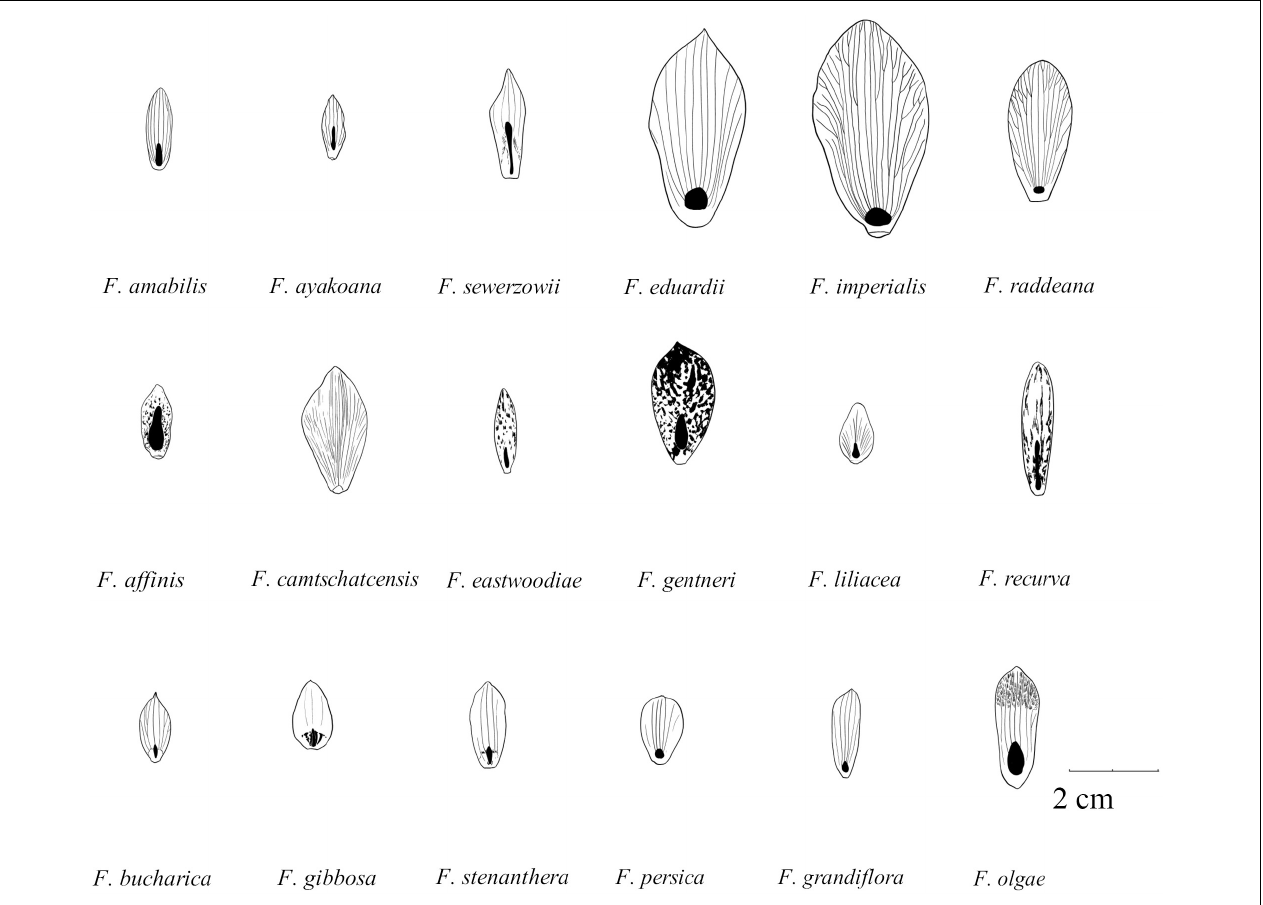
FIGURE 2 | Schematic drawings of outer tepals and nectaries (filled with black) in selected species of subgenera: Japonica ( F. amabilis and F. ayakoana ) ; Petilium ( F. eduardii, F. imperialis, and F. raddeana ); Liliorhiza ( F. affinis, F. camschatcensis, F. eastwoodiae, F. gentneri, F. liliacea, and F. recurva ) ; Rhinopetalum ( F. bucharica, F. gibbosa, and F. stenanthera ) ; Korolkowia ( F. sewerzowii ) ; Theresia ( F. persica ); and other species ( F. olgae and F. tubiformis ) (Drown by Jan